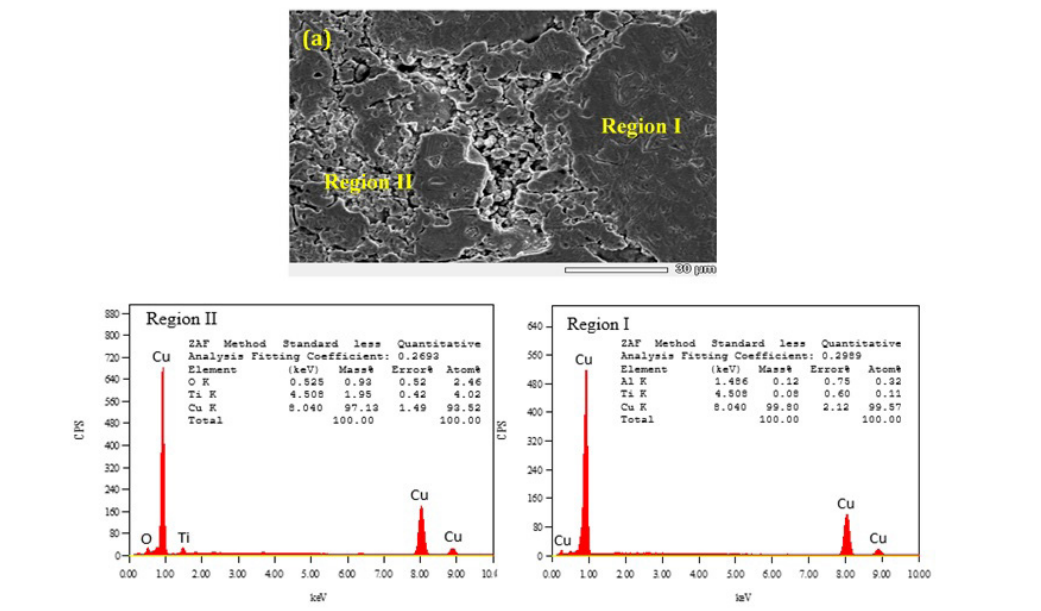
of different regions of SEM in (a). 2